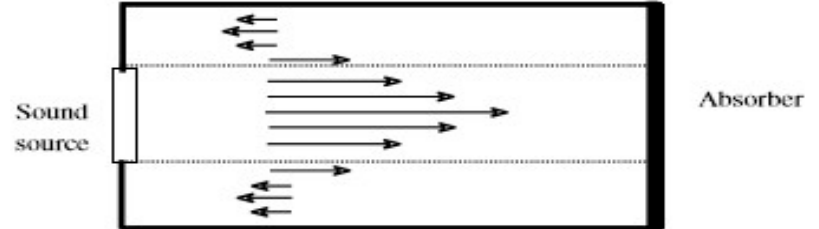
Figure 1. Acoustic streaming generated by a finite acoustic beam in a closed tube. Reproduced with permission from [34].